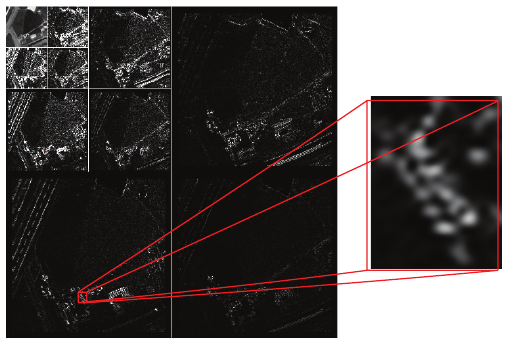
Figure 1: The wavelet transform of high resolution remote sensing image with a zoom on some